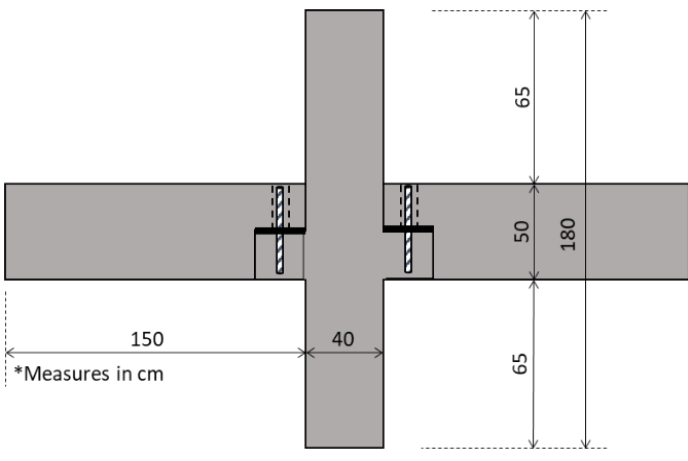
Figure 2. Basic model analyzed.